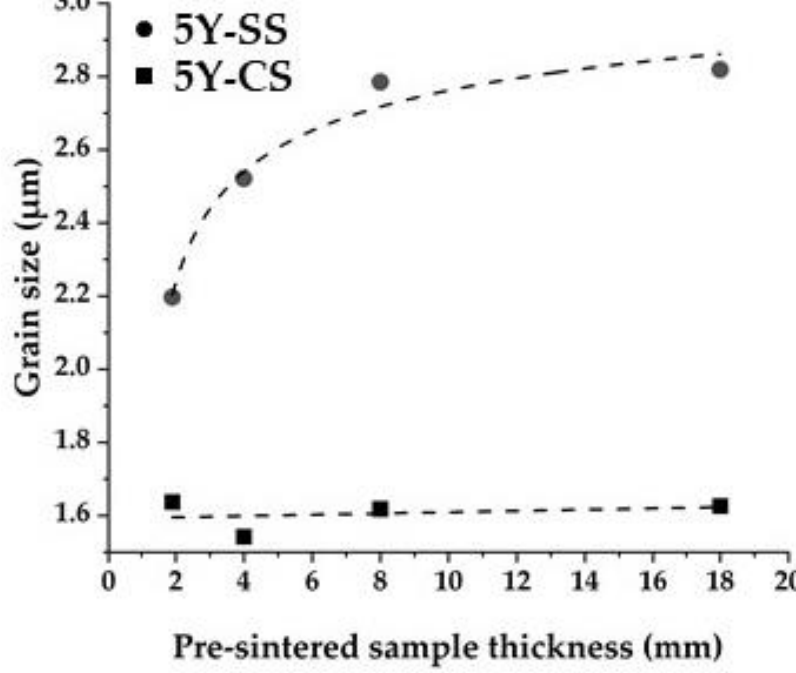
Figure 9. Relationship between the specimen ’s pre-sintered thickness and the crystal grain size.